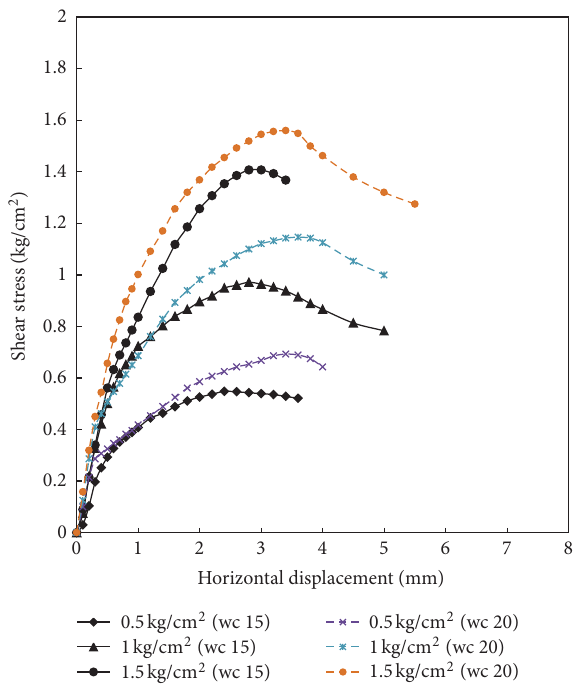
F 10: Vertical displacement versus horizontal displacement obtained from direct shear